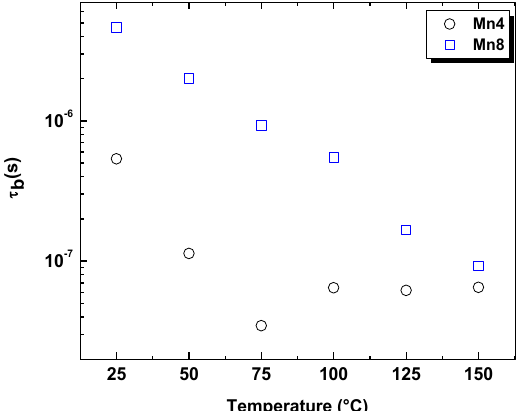
Nanomaterials 2019 , 9 , x FOR PEER REVIEW Figure 6. Effect of temperature on bulk relaxation time (τ b ) for the synthesized birnessite-type material.